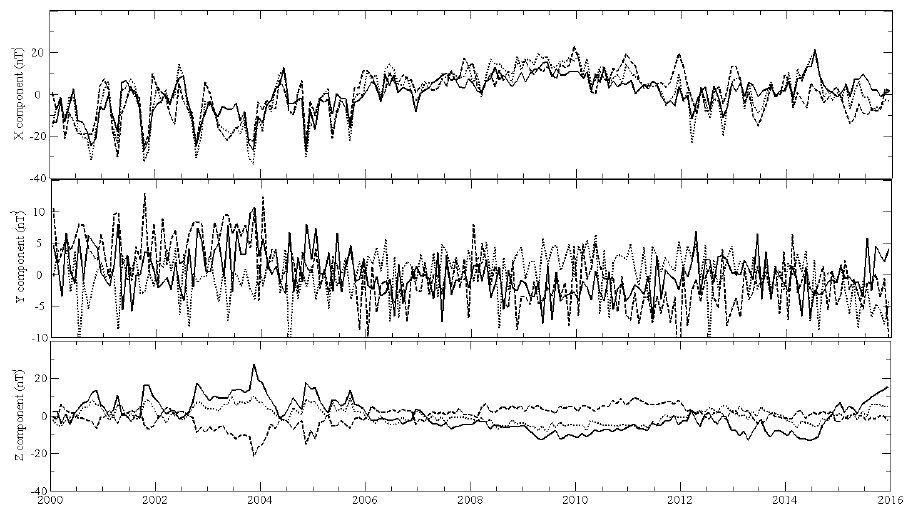
Figure 14. The external contribution (by POMME-9 model) to: a) NGK observatory (solid line), b) HER observatory (dashed line), c) KAK observatory (dotted